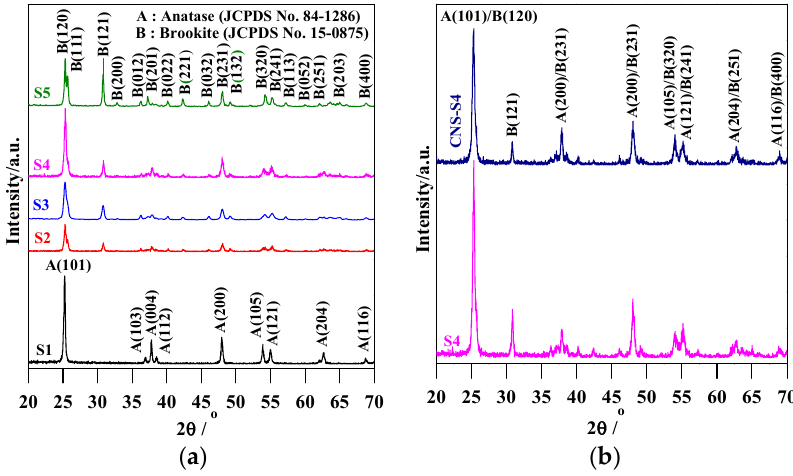
Figure 1. XRD patterns of: ( a ) S1, S2, S3, S4 and S5; and ( b ) S4 and CNS-S4.